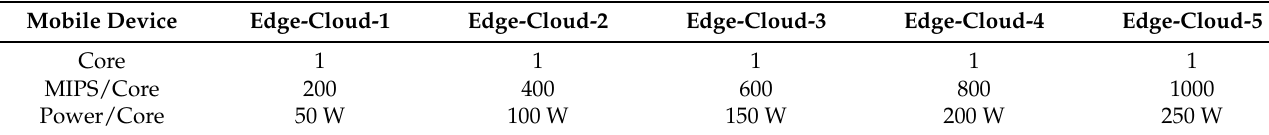
Table 4. Mobile Edge-Cloud Resource